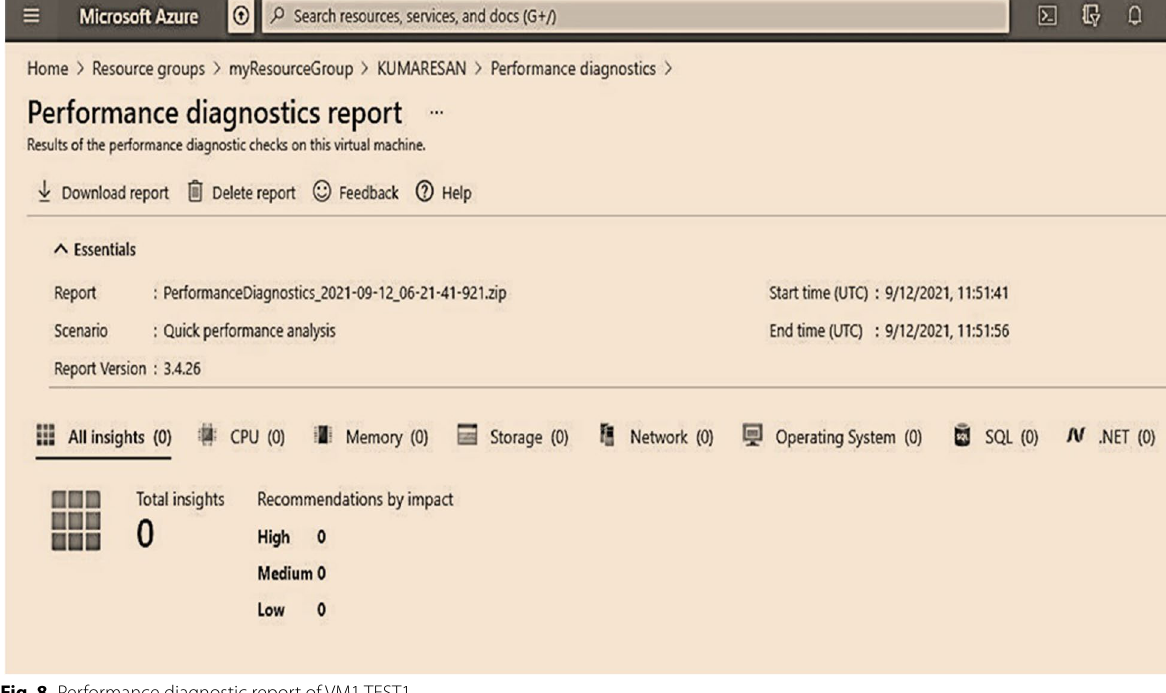
Fig. 8 Performance diagnostic report of VM1 TEST1